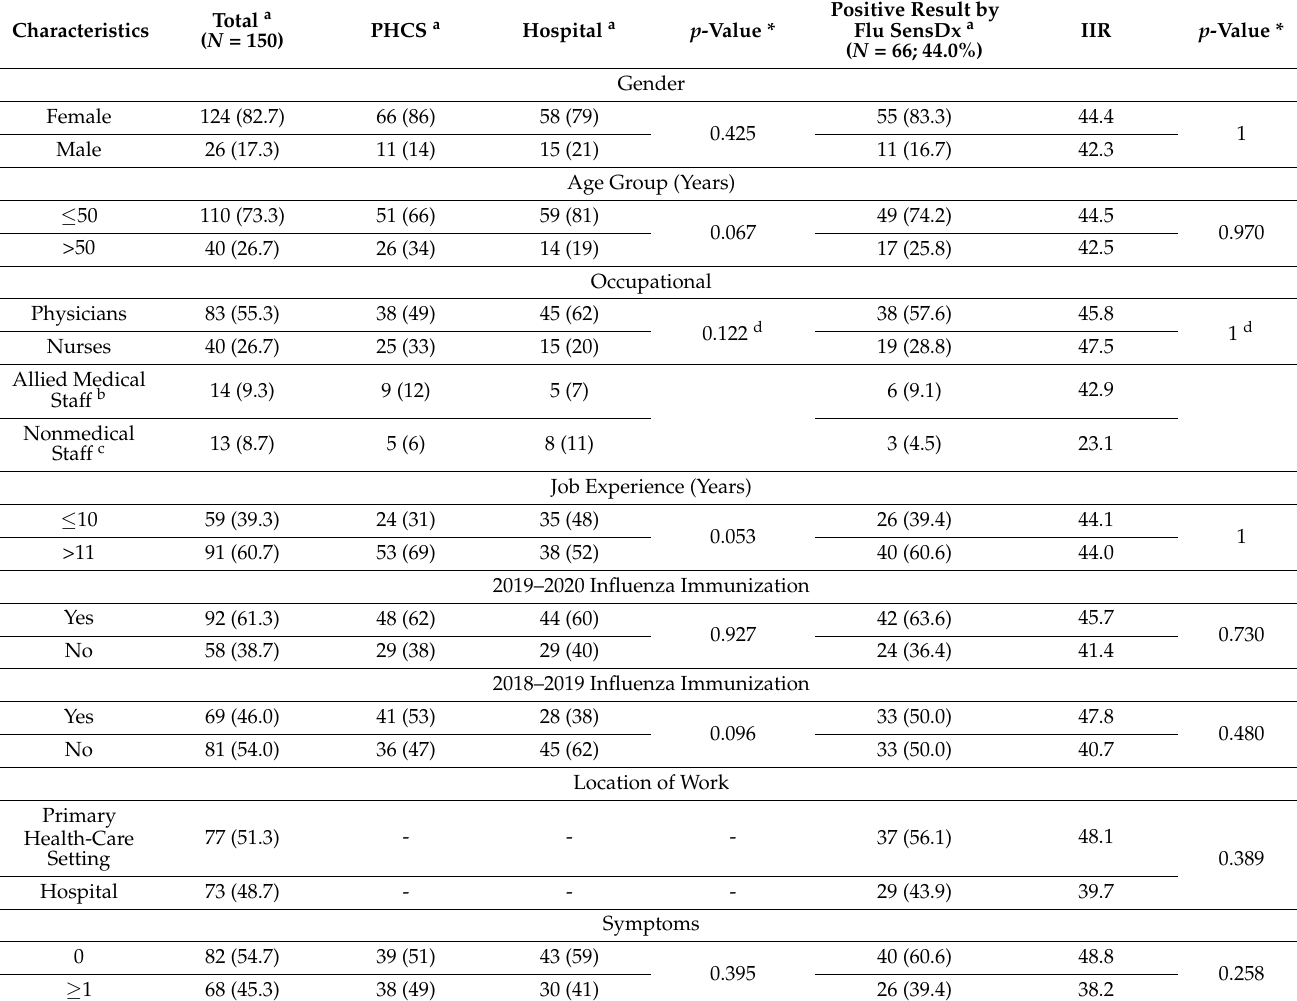
Table 1. Characteristics of the study